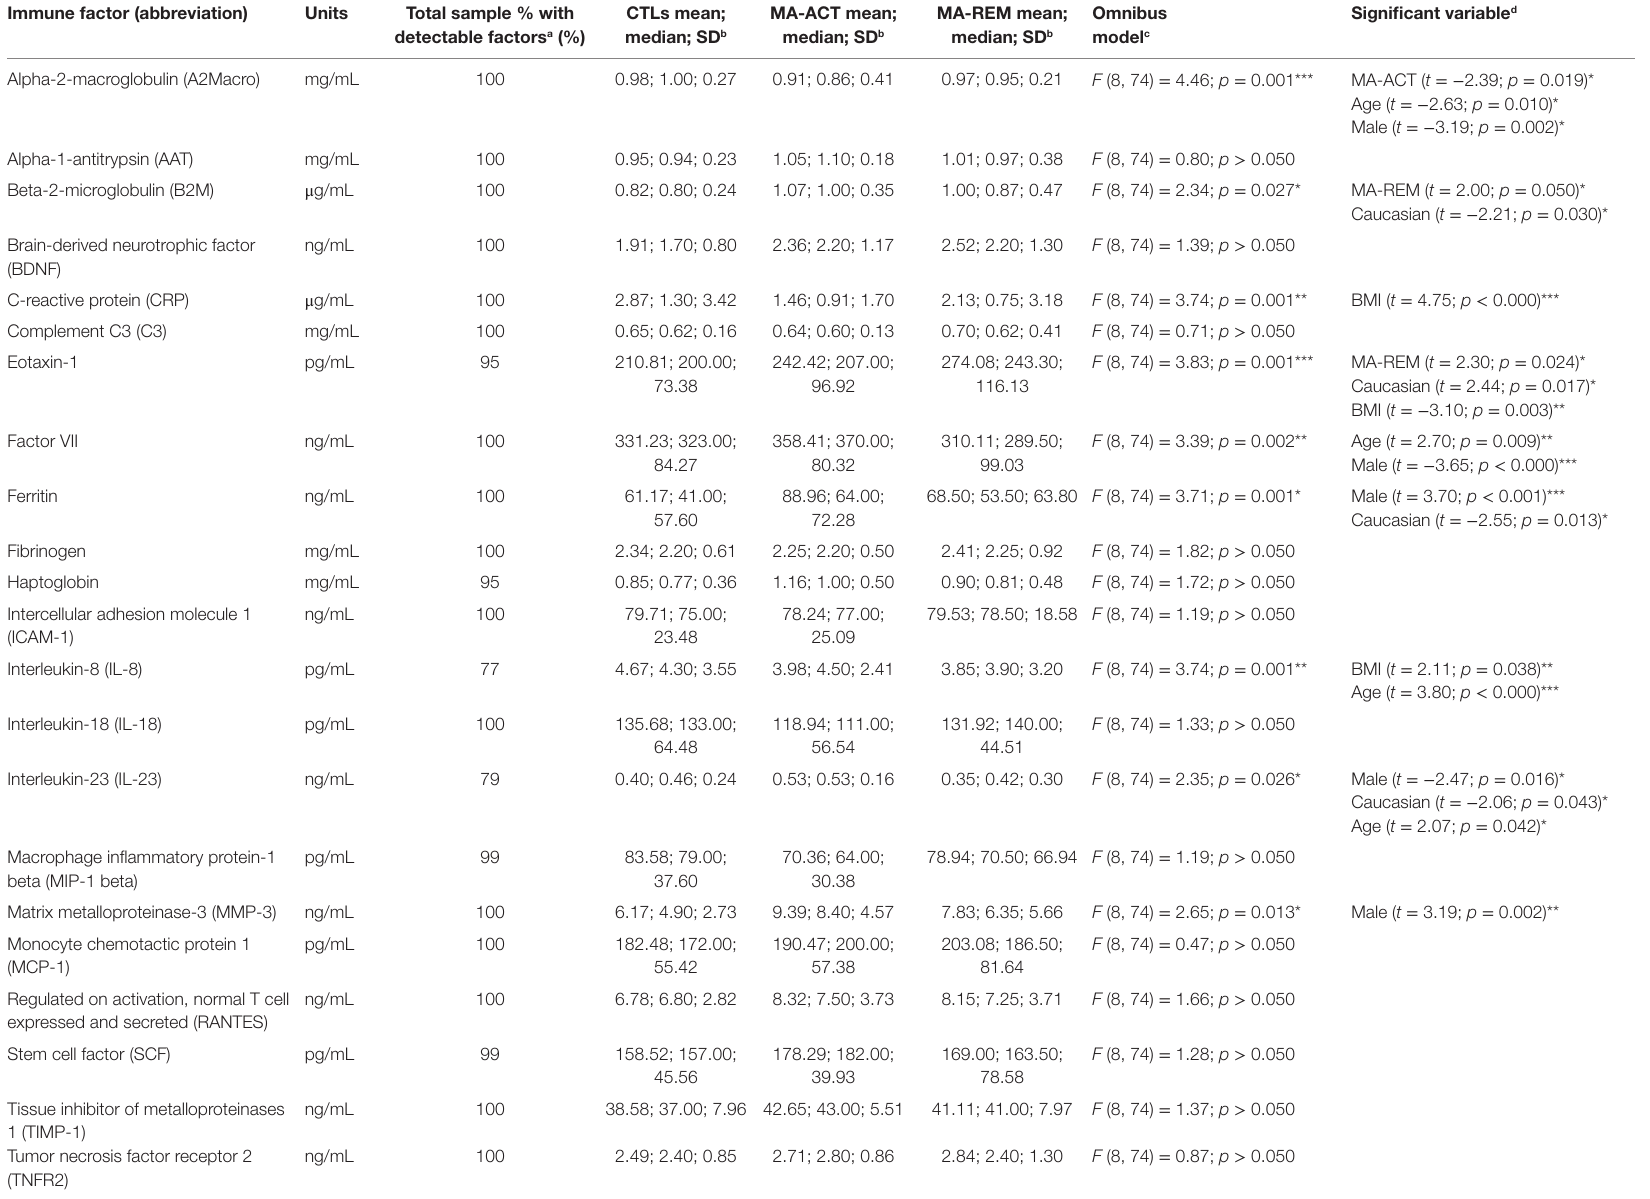
TaBle 2 | covariate analysis of plasma immune factor levels in adults with and without methamphetamine